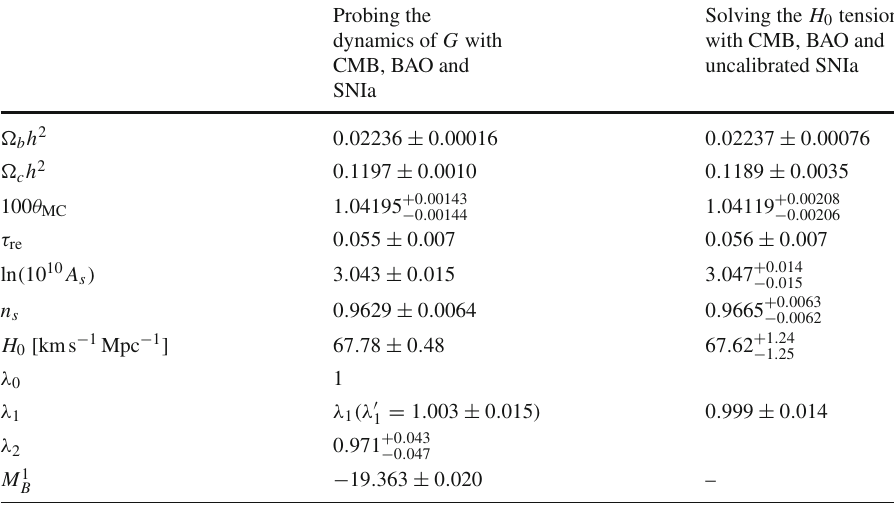
Table 1 The 68% limits for the cosmological parameters in two models for different purpose. ) indicates λ Notice that λ 1 (λ (cid:7) 1 1 is a function of λ (cid:7)